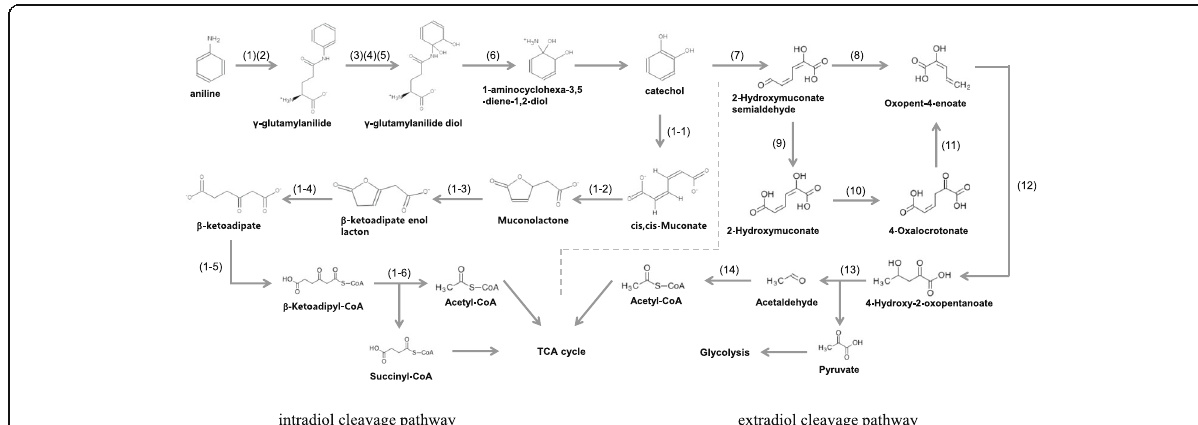
Fig. 2 Two metabolic pathway of aniline degradation in Delftia sp. K82. Two metabolic pathways (an intradiol cleavage pathway and an extradiol cleavage pathway) of aniline degradation in Delftia sp. K82 have been identified. Enzymes of each pathway are numbered and are listed in Table 3. The aniline oxygenase complex of Delftia sp. K82 is composed of six enzymes (Nos. 1 ∼ 6) and four reaction steps for the conversion of aniline into catechol. The